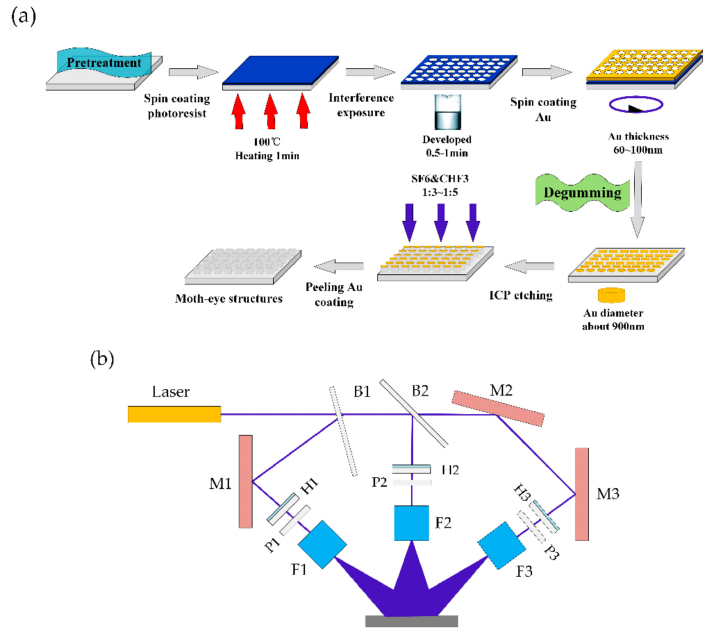
Figure 6. Fabrication process of moth-eye structure with a waist. ( a ) Processing flow of TIL and ICP etching; ( b ) schematic setup of the TIL system: B-Beam splitter (B1, B2), M-Mirror (M1, M2, M3), W-1/4 wave plate (W1, W2, W3), P-Polarizer (P1, P2, P3), L-Lens (L1, L2, L3) and PH-Pinhole (PH1, PH2, PH3).